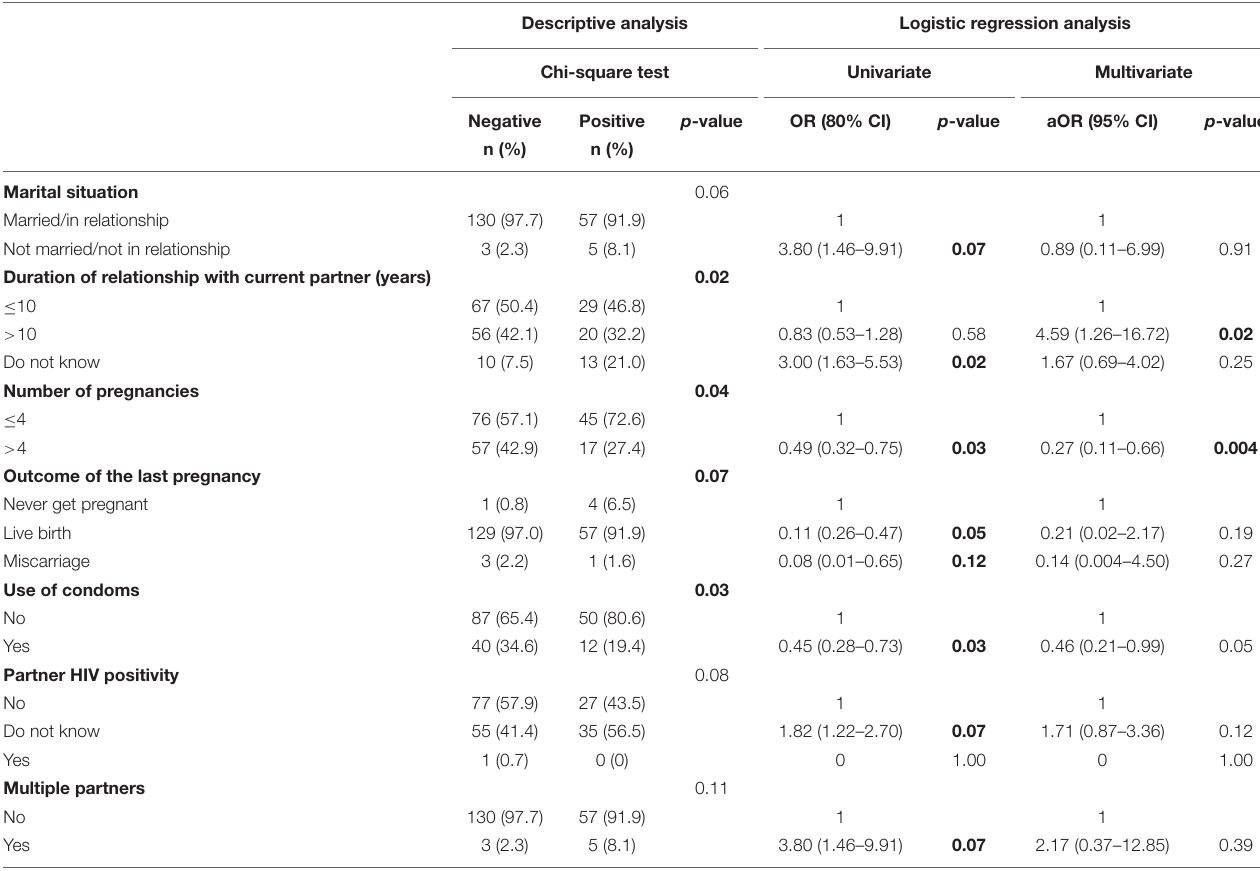
TABLE 4 | Descriptive and logistic regression analysis of factors associated with